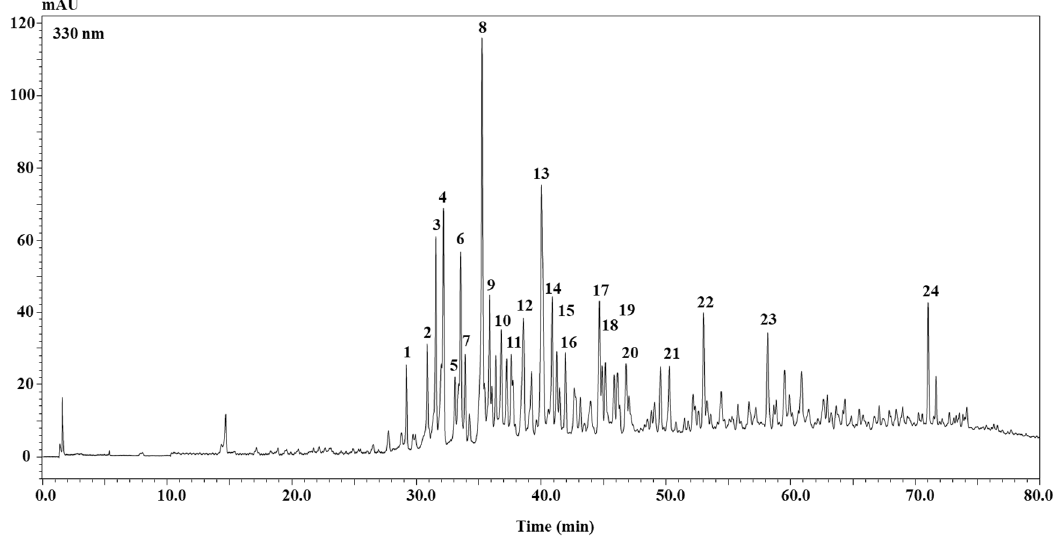
Figure 1. HPLC-PDA chromatograms of the polyphenolic compounds, extracted at 330 nm wavelength, of B. fruticulosa subsp. fruticulosa leaf hydroalcoholic extract. For peak identification, see Table 1.